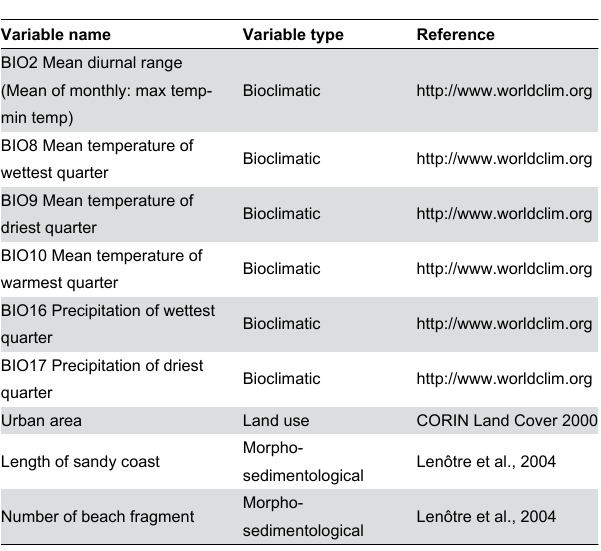
Table 1. Variables used in the